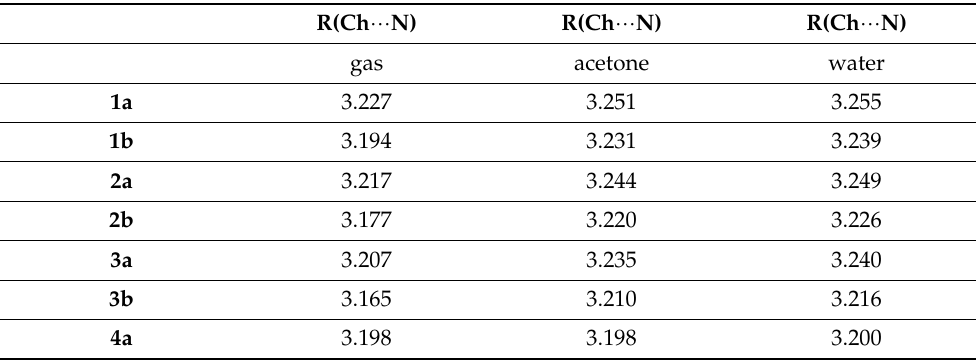
Table 2. Intermolecular distances (Å) in